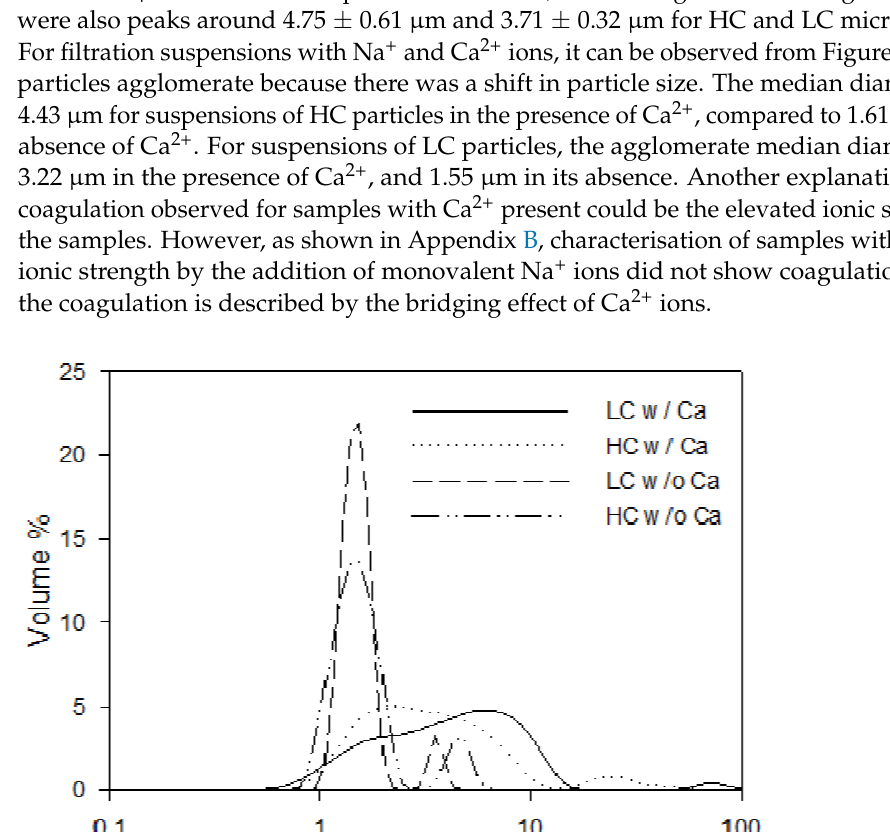
( b ) Figure 4. Decline in relative flux during 1000 s membrane fouling by filtration of low surface charge ( a ) and high surface charge ( b ) PS–PAA particles with and without calcium ions. Line breaks in the curves are caused by emptying the perme- ate beaker.